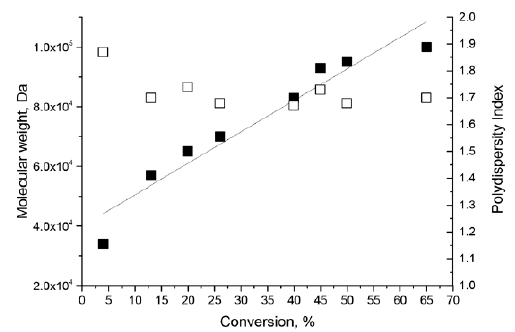
Figure 11. Molecular weight (left axis, filled squares) and polydispersity index (right axis, open squares) evolution vs. conversion plot for bulk polymerization of styrene initiated with alkoxyamine 8 at 130 ◦ C with styrene / 8 ratio 5000:1. Dotted line for the theoretical evolution of Mn. Audran, G.; Bagryanskaya,